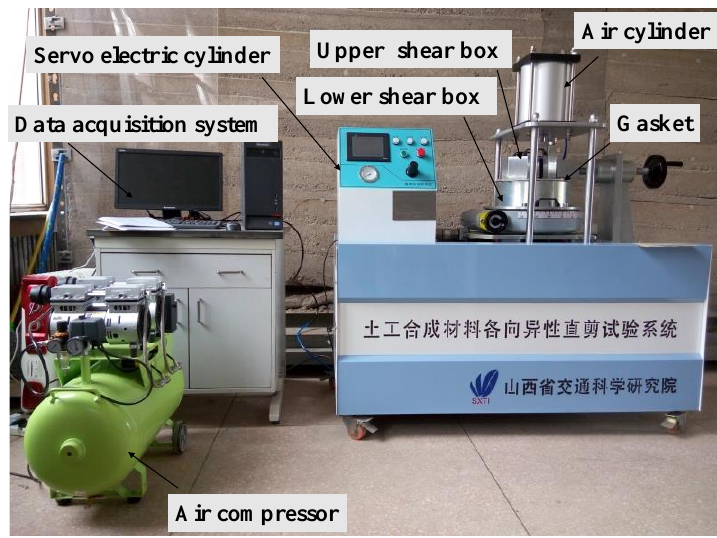
Figure 2. Interface shear test apparatus.